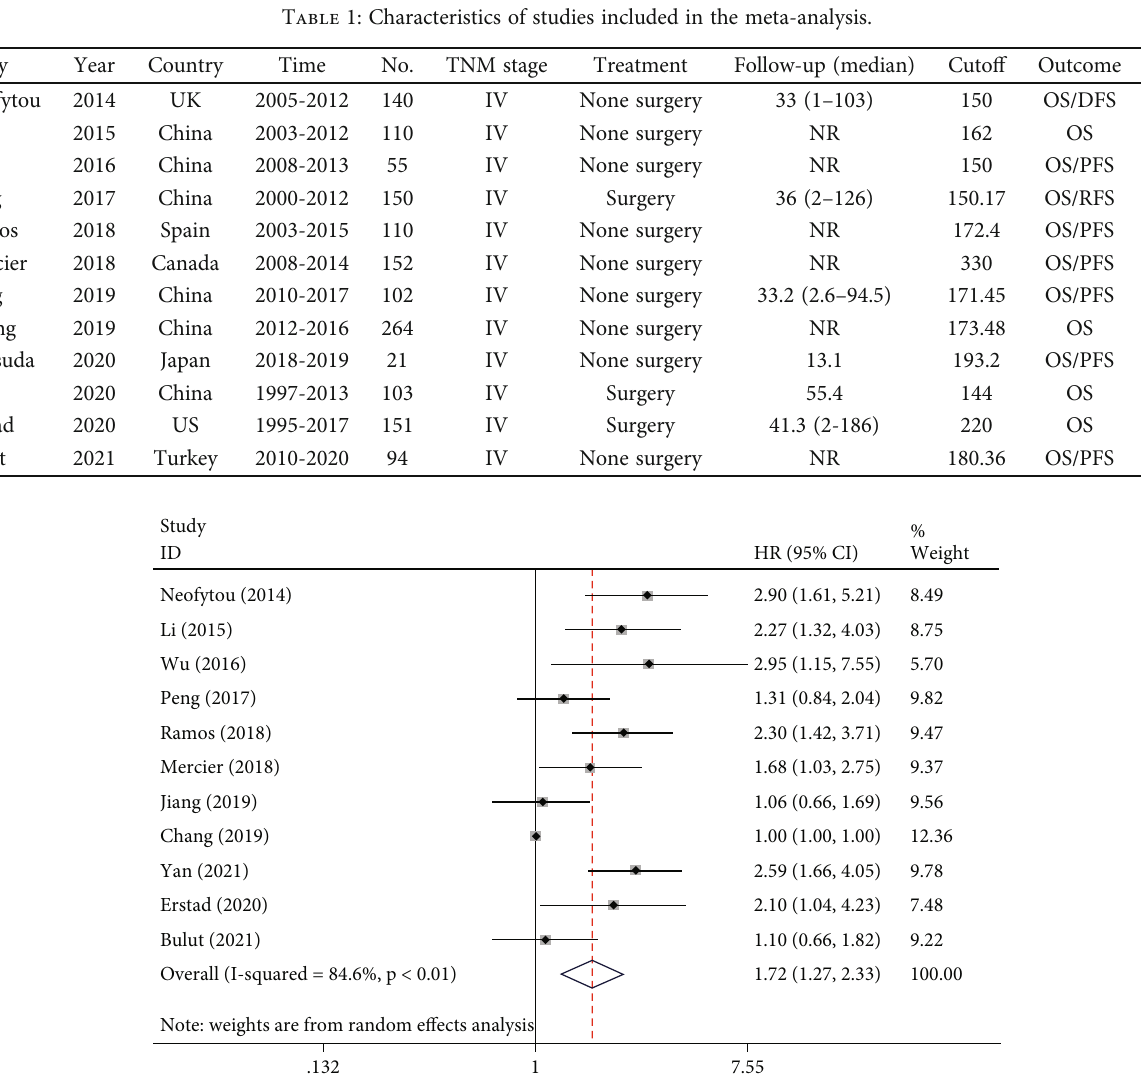
Figure 2: Results of prognostic analysis for PLR in mCRC for